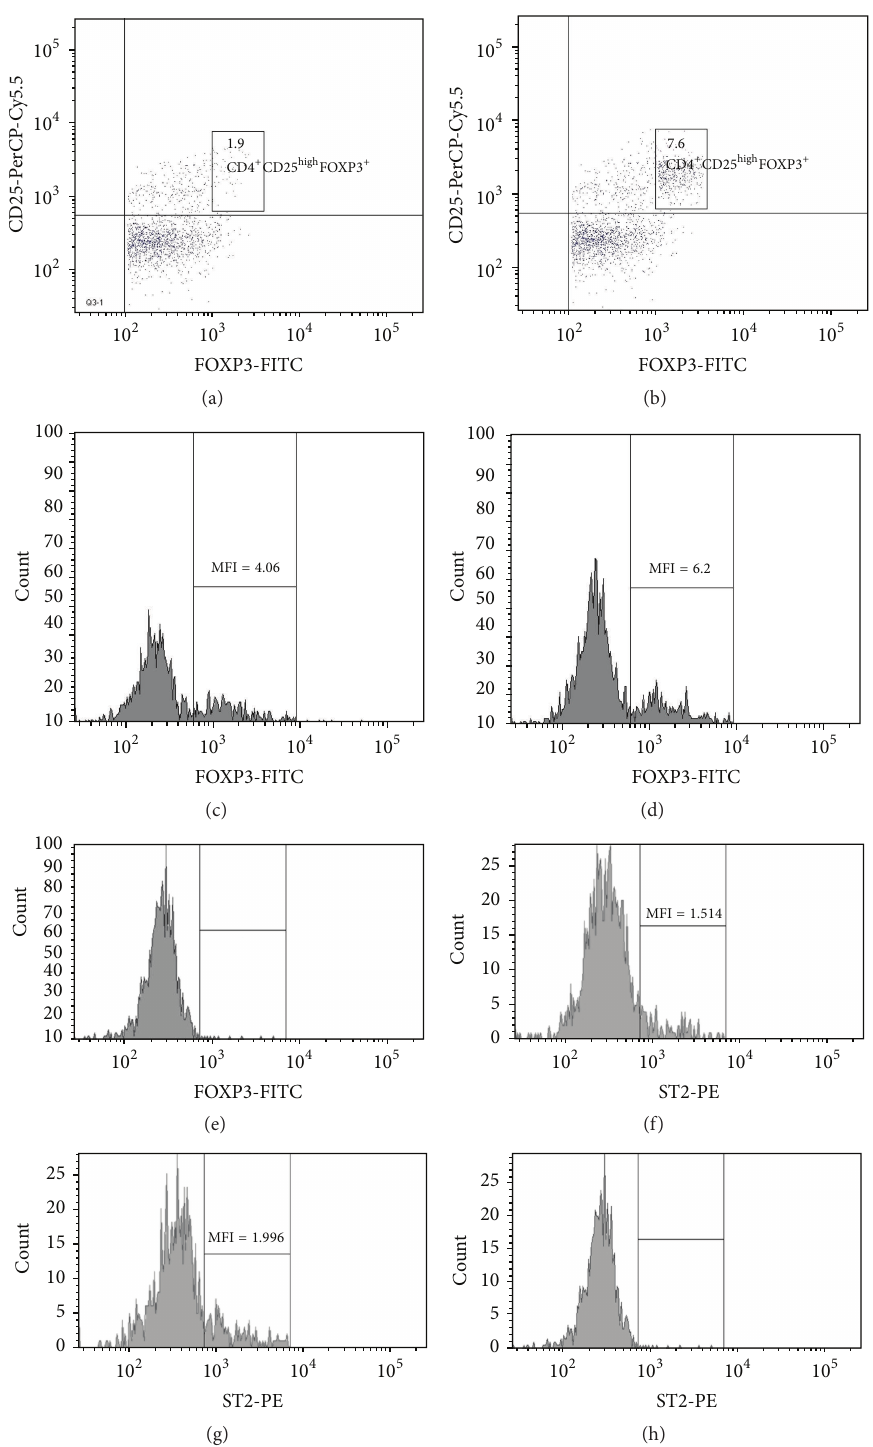
Figure 1: Representative flow cytometric analysis of CD 4 + CD 25 high FOXP 3 + T cells in DM1 patient after in vitro IL-33 treatment. PBMCs from diabetic type 1 patient were cultured and stimulated as described in Material and Methods, stained with antibodies against Treg associated molecules, and analyzed using flow cytometry. Analyzing CD 4 + CD 25 high FOXP 3 + T cells, dot plots representing anti-CD4 versus SS were carried out to establish CD4 + and CD4 − lymphocyte gates. Then, the following dot plots were generated: anti-CD4 versus CD127 from CD4 + gate. After gating on CD4 + 127 − cells, the frequency of nonstimulated (a) and IL-33 stimulated (b) CD 4 + CD 25 high FOXP 3 + cells was determined. Gated, nonstimulated (c) and IL-33 stimulated (d) CD 4 + CD 25 high FOXP 3 + T cells were checked for the expression of FOXP3 definedasMeanFluorescenceIntensity.Similarly,theexpressionofST2onnonstimulated(f)andIL-33stimulated(g)CD 4 + CD 25 high FOXP 3 + was analyzed. During the analysis isotypes controls for FOXP3 (e) and ST2 (h) staining were used. MFI: Mean Fluorescence